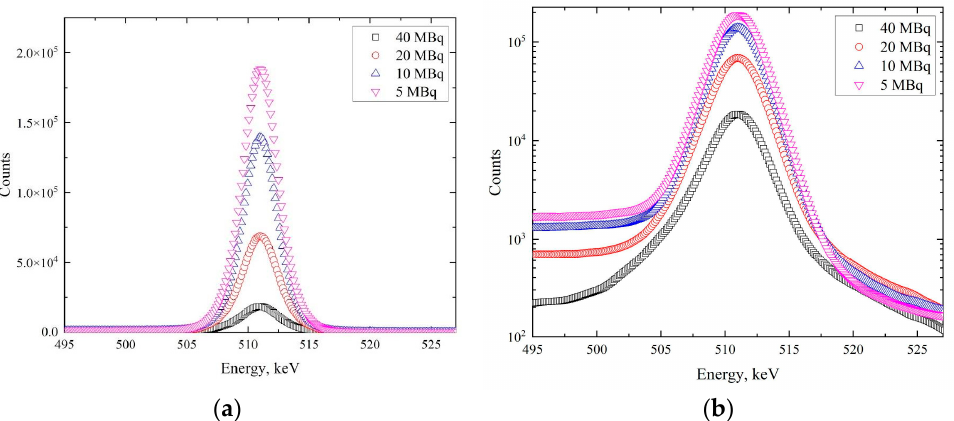
Figure 4. Energy spectra of annihilation line at the different activity levels of the 64 Cu isotope: linear scale ( a ), logarithmic scale ( b ).